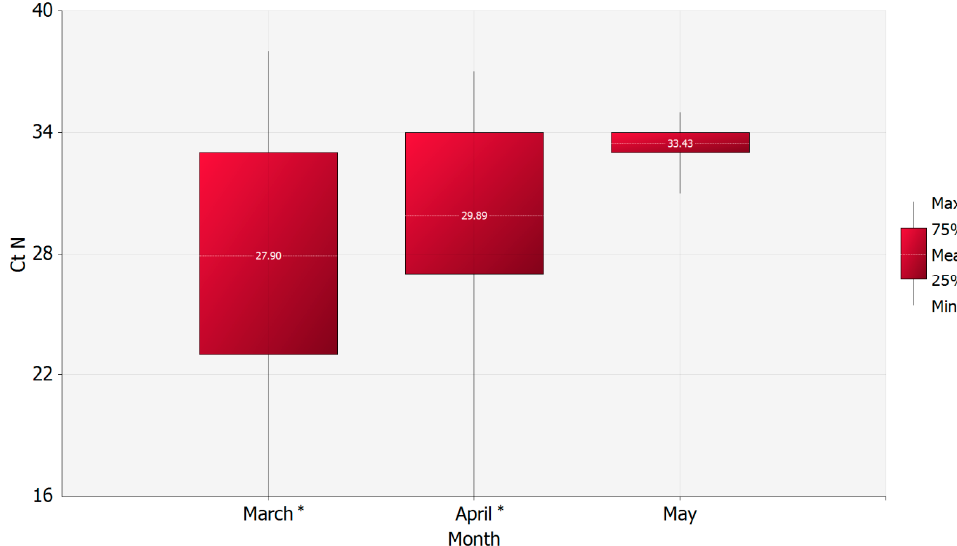
Figure 2. Mean values of CT N gene of the first positive swab per patient by month. *Asterisks are denoting the significant mean value of CT N gene ( p -value = 0.0002).